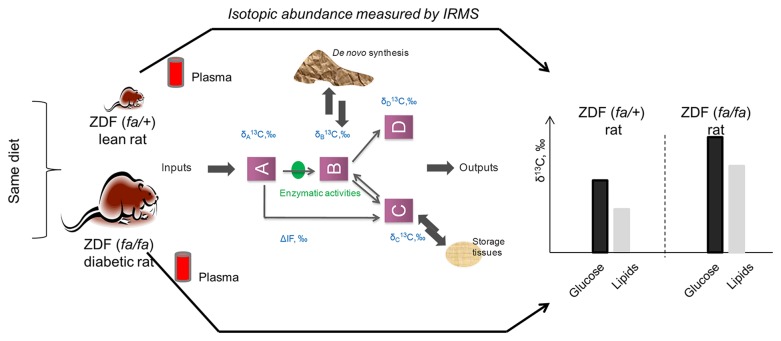
Synopsys of the exploratory study studying the relative impact of the pathophysiological conditions (ZDF (fa/+) and ZDF (fa/fa) rats) on the natural carbon isotopic abundance (δ13C) for individual metabolites measured in plasma, in breath and liver tissue samples by isotope ratio mass spectrometry.